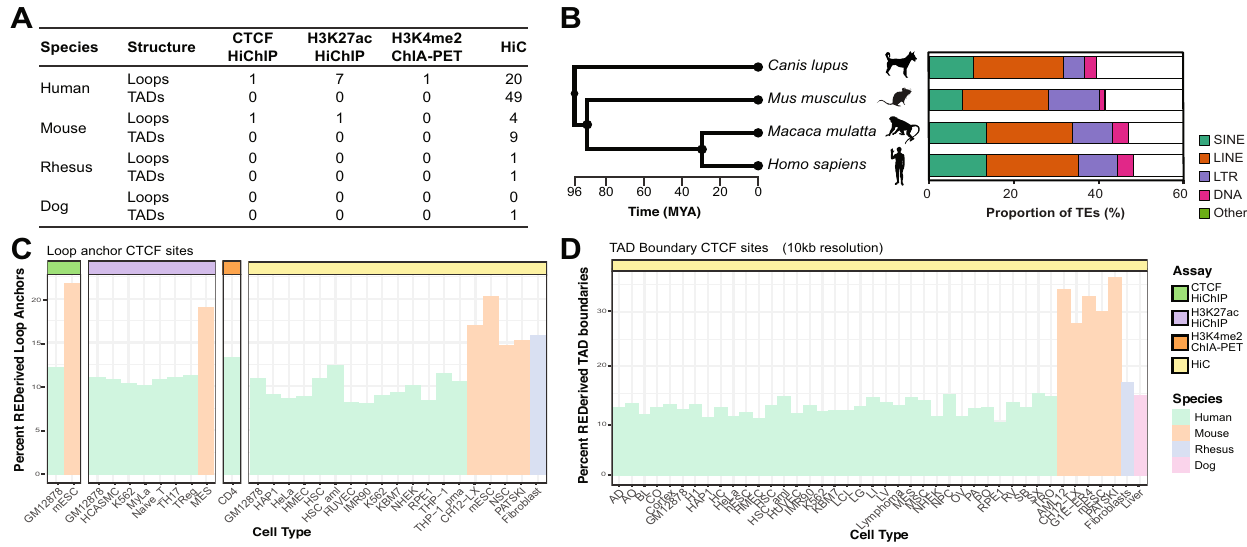
Fig. 1 | Contribution of repeats to loop anchor and TAD boundary CTCF sites across4species.A Catalogofpubliclyavailabledatasetsusedaspartofthisstudy. B Phylogenetictreeofthefourmammals(left).ContributionofTEsbyclasstototal